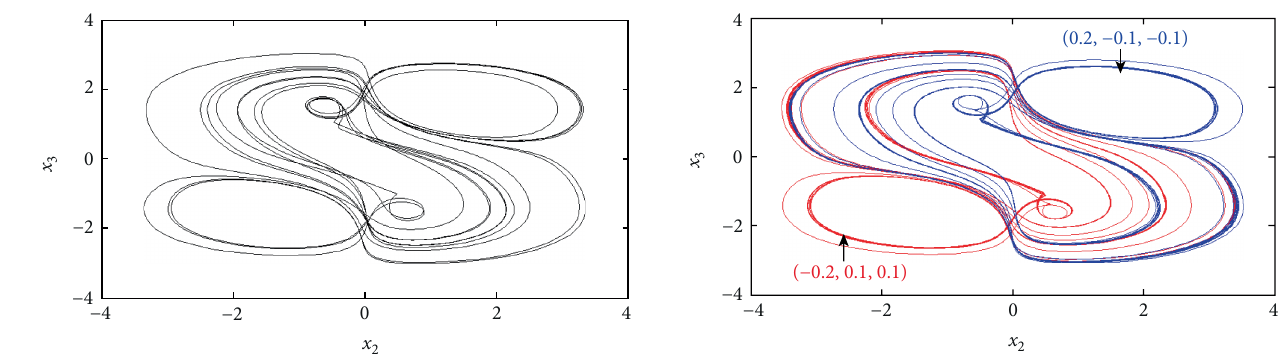
Figure 3: Four-scroll chaotic attractors in fractional-order memristive system